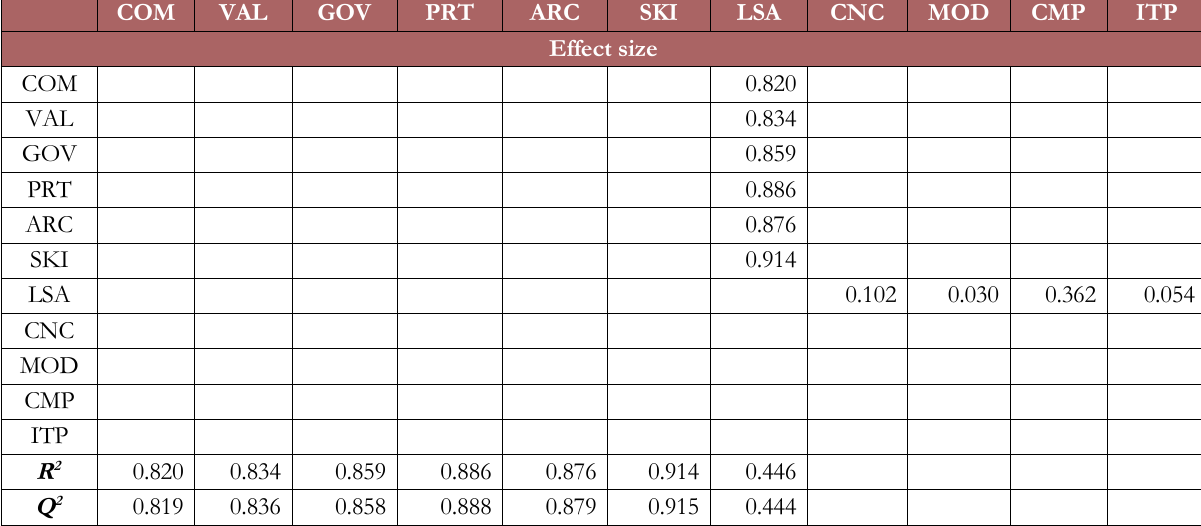
Table 5. Psychometric properties of structural